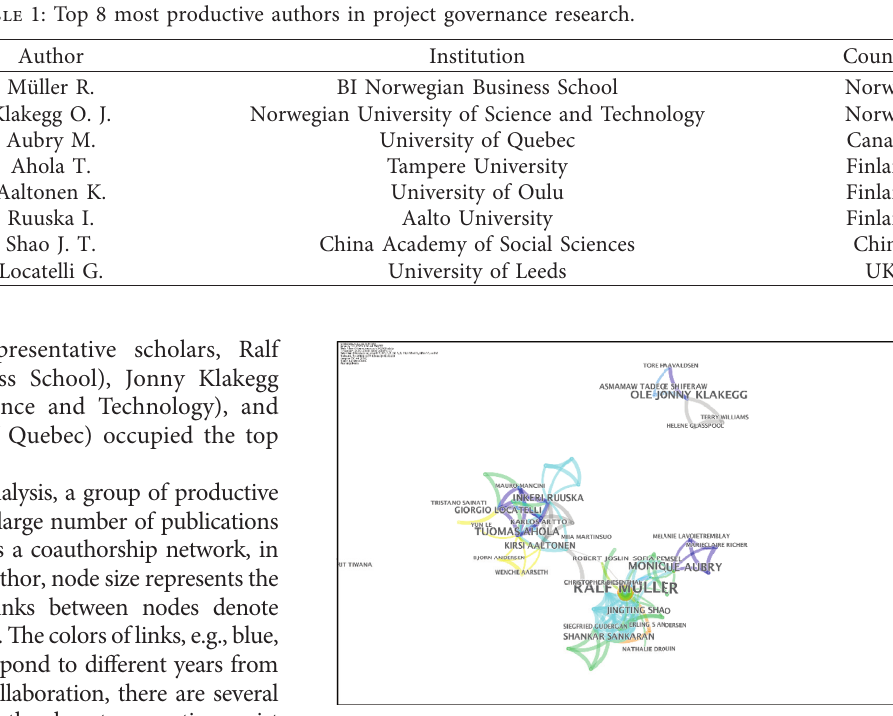
Figure 3: Coauthorship network of authors in project governance